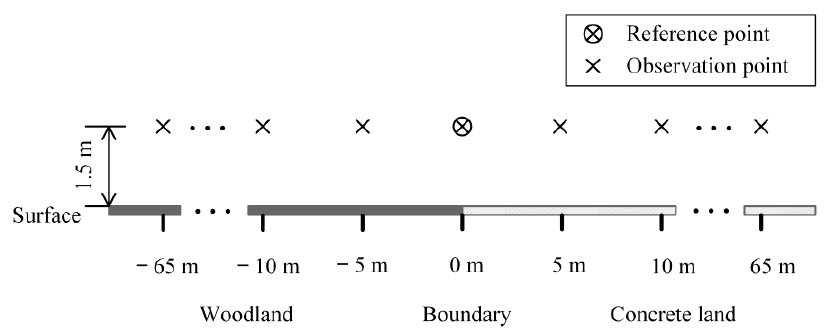
Figure 1. Schematic of the field measurement.